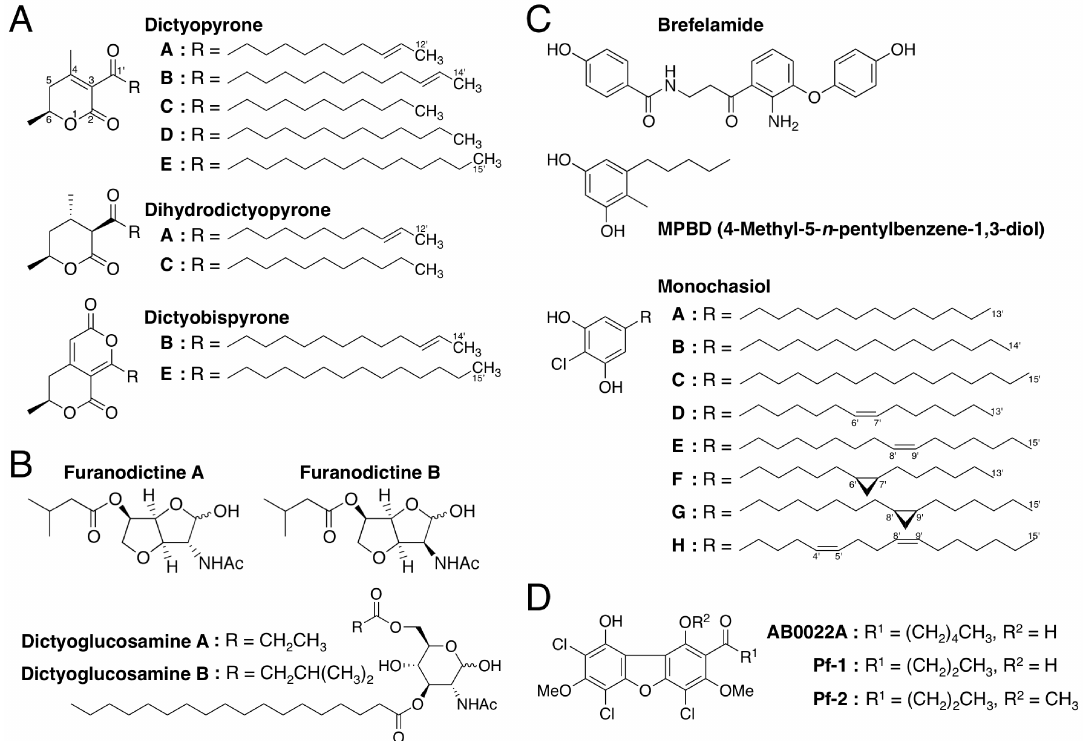
Figure 10. Chemical structures of secondary metabolites isolated from cellular slime molds. ( A ) dictyopyrones; ( B ) furanodictines; ( C ) Brefelamide, MPBD and Monochasiols; ( D ) AB0022A, Pf ‐ 1 and Pf ‐